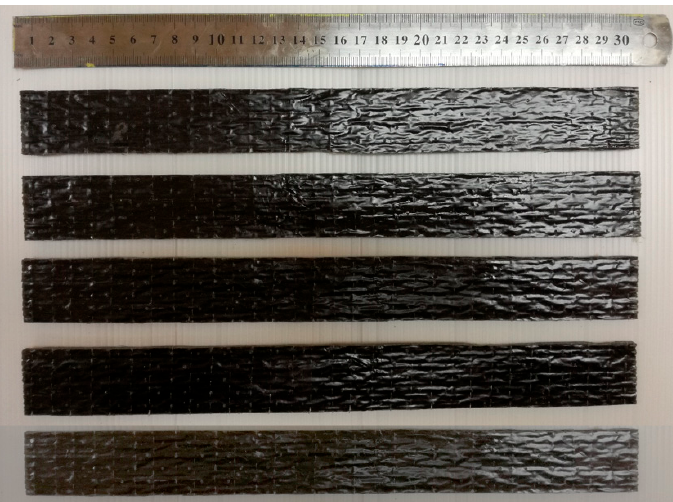
Figure 1. Examples of fabricated unmodified basalt fiber reinforced polymer (BFRP) composite samples. Table 1. Specimen labels and details.